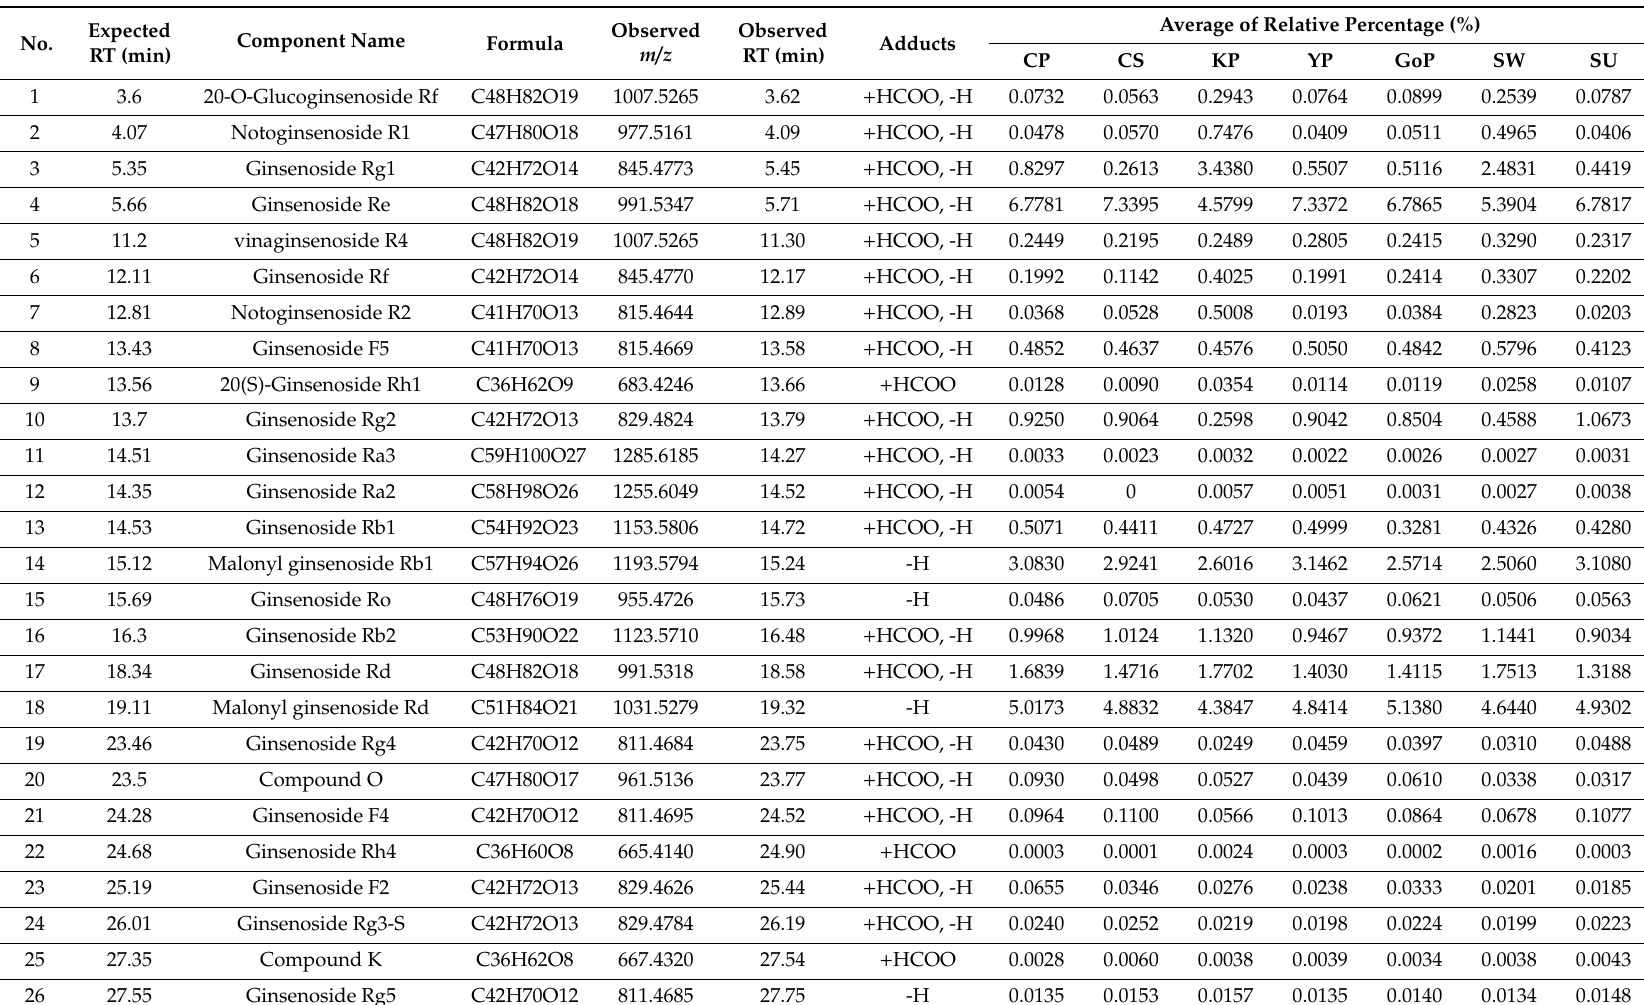
Table 1. Relative percentages of ginsenosides in each cultivar